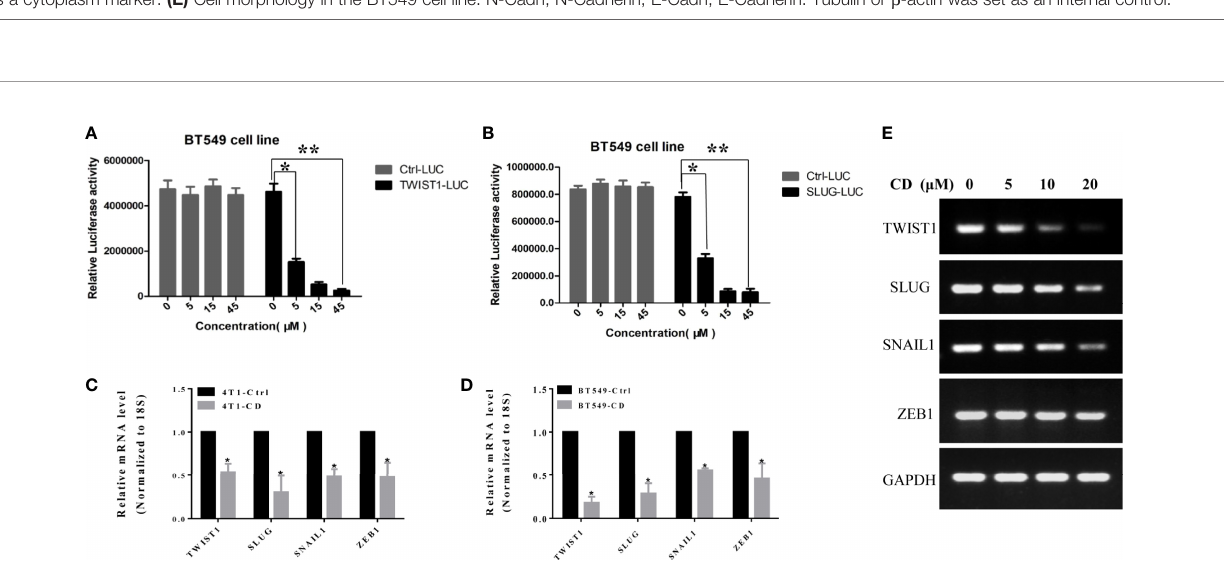
FIGURE 4 | Effects of cordycepin on the TWIST1 or SLUG reporter activity. (A) Luciferase reporter assay showed that CD decreased the TWIST1 reporter activity in Hela cells, as the relative light unit (RLU) was decreased with the increase in CD dosage. (B) Luciferase reporter assay showed that CD reduces the SLUG reporter activity in Hela cells, as the Relative Light Units (RLU) were reduced with the increase of CD dosage. *P < 0.05, **P < 0.01. (C, D) The levels of mRNA for TWIST1 , SLUG , SNAIL1 , and ZEB1 in 4T1 or BT549. 4T1 or BT549 cells were treated with 10 µM of CD for 24 h, total RNA was extracted, and quantitative RT-PCR analysis was performed. (E) The levels of mRNA for TWIST1 , SLUG , SNAIL1 , and ZEB1 in BT549 were treated with the indicated concentration of CD. BT549 cells were treated with 0, 5, 10, and 20 µM of CD for 24 h, total RNA was extracted, and semiquantitative RT-PCR and quantitative RT-PCR analyses were